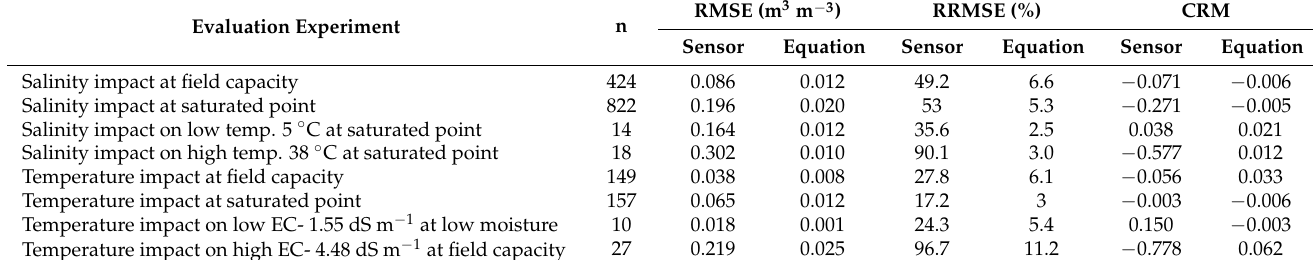
Table 9. Statistical analysis of performance comparison of sensor and proposed L&O correction equation for correcting gradual increase in salinity and temperature on sensor readings as determined by RMSE, RMSE, and CRM in field capacity and saturated point moisture.